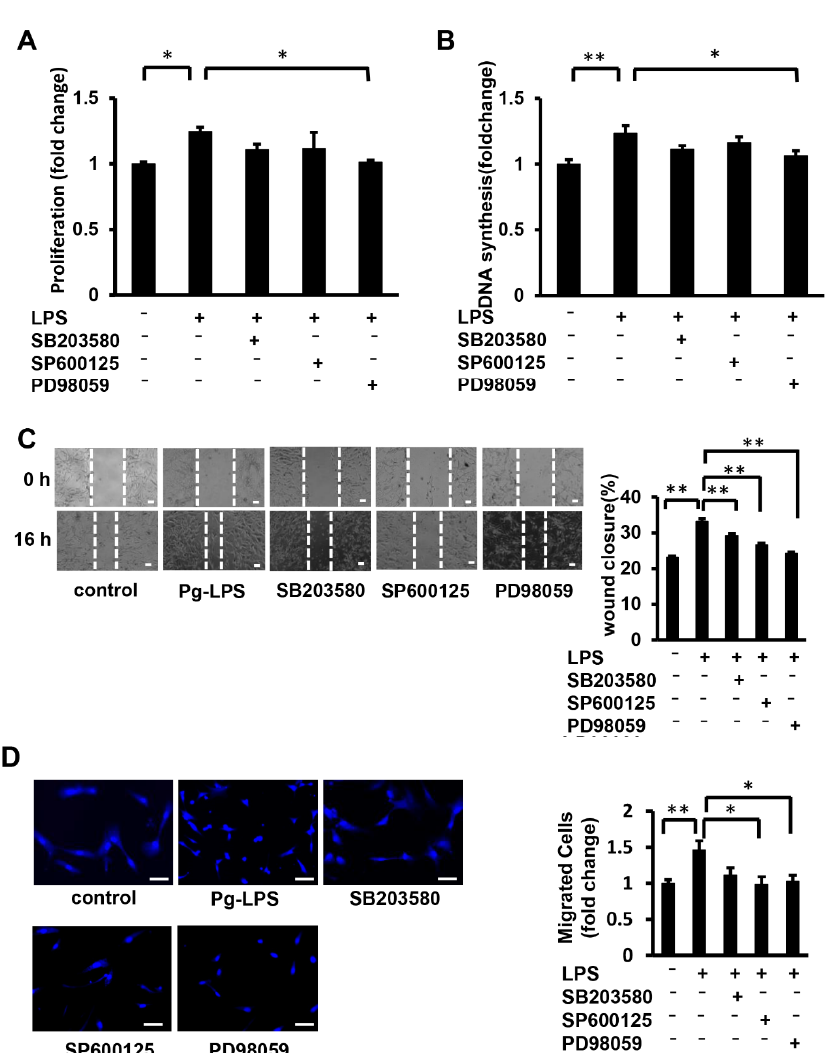
Figure 7. ERK inhibition suppresses Pg -LPS-stimulated HASMC proliferation and migration, while P38 MAPK and SAPK/JNK inhibition suppress migration. ( A ) The effect of MAPK inhibition on the cell number of Pg -LPS-stimulated HASMCs. HASMCs were pretreated with PD98059 (an ERK in- hibitor), SB203580 (a p38 MAPK inhibitor), and SP600125 (an SAPK/JNK inhibitor) for 1 h, stimu- lated with Pg -LPS (100 ng/mL) for 16 h, and then evaluated using the MTT assay. n = 6 in each group. ( B ) The effect of MAPK inhibition on DNA synthesis in the Pg -LPS-stimulated HASMCs. HASMCs were pretreated with inhibitors and stimulated with Pg -LPS (100 ng/mL) for 16 h. Cells were then labeled with BrdU for 16 h. n = 6 in each group. ( C ) Effect of MAPK inhibition on the migration of Pg -LPS-stimulated HASMCs. Upper panels show the representative scratch wound healing assay. The lower panel shows the quantitative wound closure rate analyses. HASMCs were pretreated with inhibitors for 1 h and directly scratched. Cells were incubated with Pg -LPS (100 ng/mL) for 16 h. n = 4 in each group. The scale bar shows 100 μ m. ( D ) The effect of MAPK inhibitors on the migra- tory property of the Pg -LPS-stimulated HASMCs. The upper panels show the representative DAPI staining of migrated cells. HASMCs were pretreated with inhibitors for 1 h. Cells were seeded in a